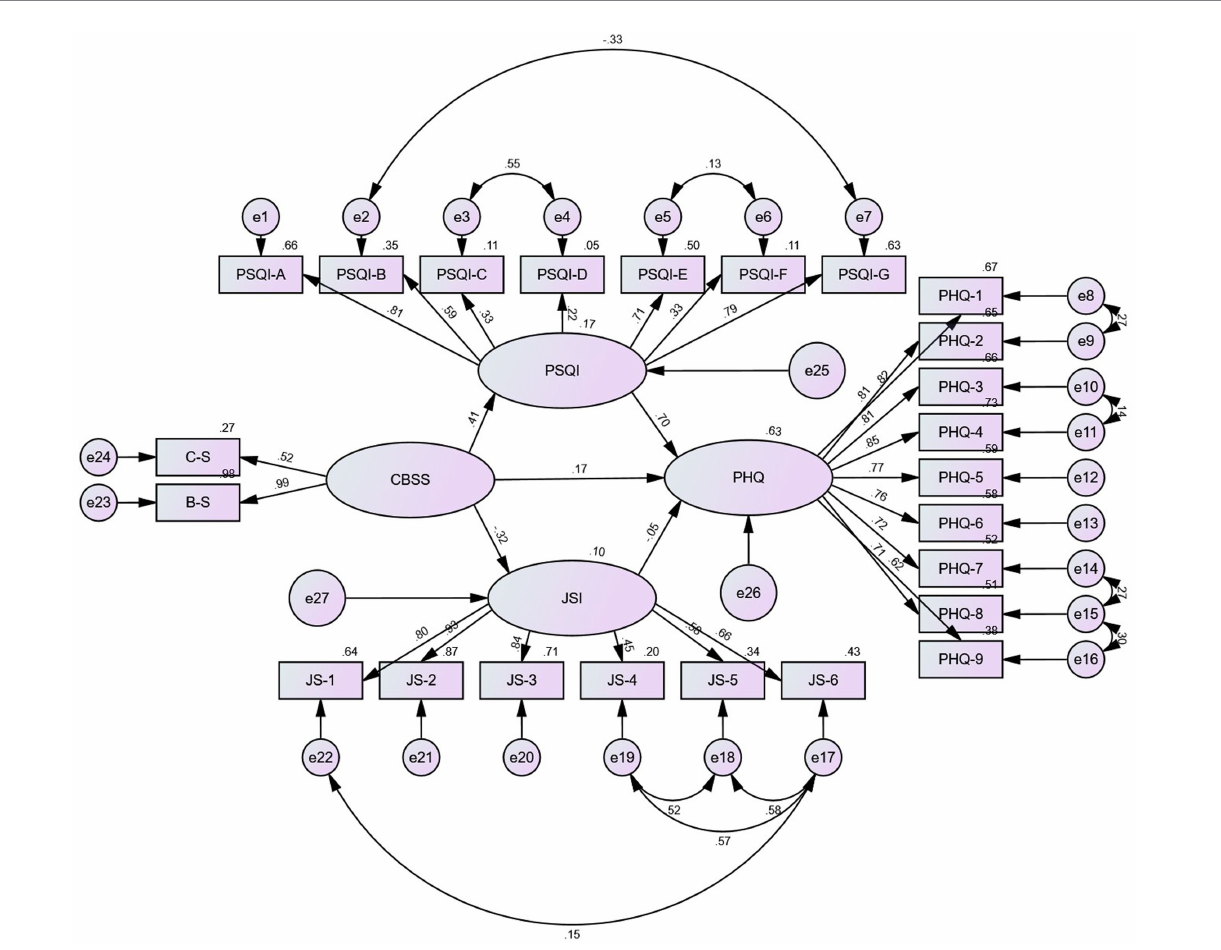
FIGURE 1 Results of the SEM analysis of the effects of sleep quality and job satisfaction mediate the association between work stress and depression among the whole sample. All the coefficients in the figure are standardized and significant at 0.001 level. Except that the path coefficient of JSI to PHQ is insignificant ( p ≥